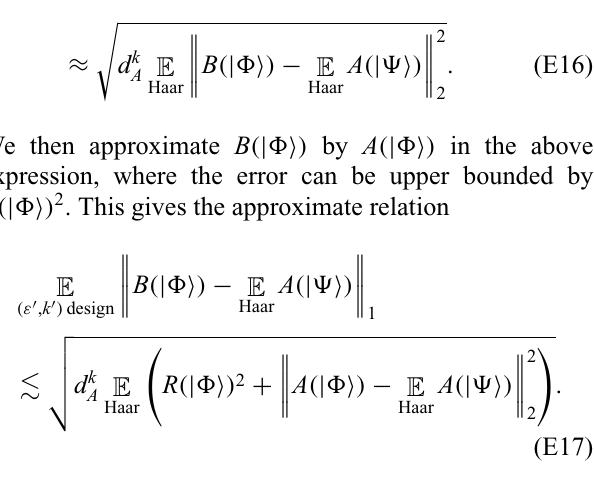
FIG. 8. A visualization of the modulating function and the concentration of d B (cid:5) (cid:26) (cid:16) z | (cid:26) (cid:16) z (cid:2) . (a) The modulating function μ k , b ( s ) defined in Eq. (E10) for varying values of b from 2 to 16. The darker colors correspond to higher b . We fix k = 2 in the plot. (b) The concentration of s = d B (cid:5) (cid:26) (cid:16) z | (cid:26) (cid:16) z (cid:2) for the Hilbert-space dimension of subsystem A , i.e., d A = 2 N A = 16, when | (cid:16) (cid:2) is sampled uniformly at random from the complex sphere. We sample 10 000 different vectors | (cid:16) (cid:2) to generate the histogram. The black solid line is a kernel-density-estimation fit of the histogram. If d A is larger, then s is more